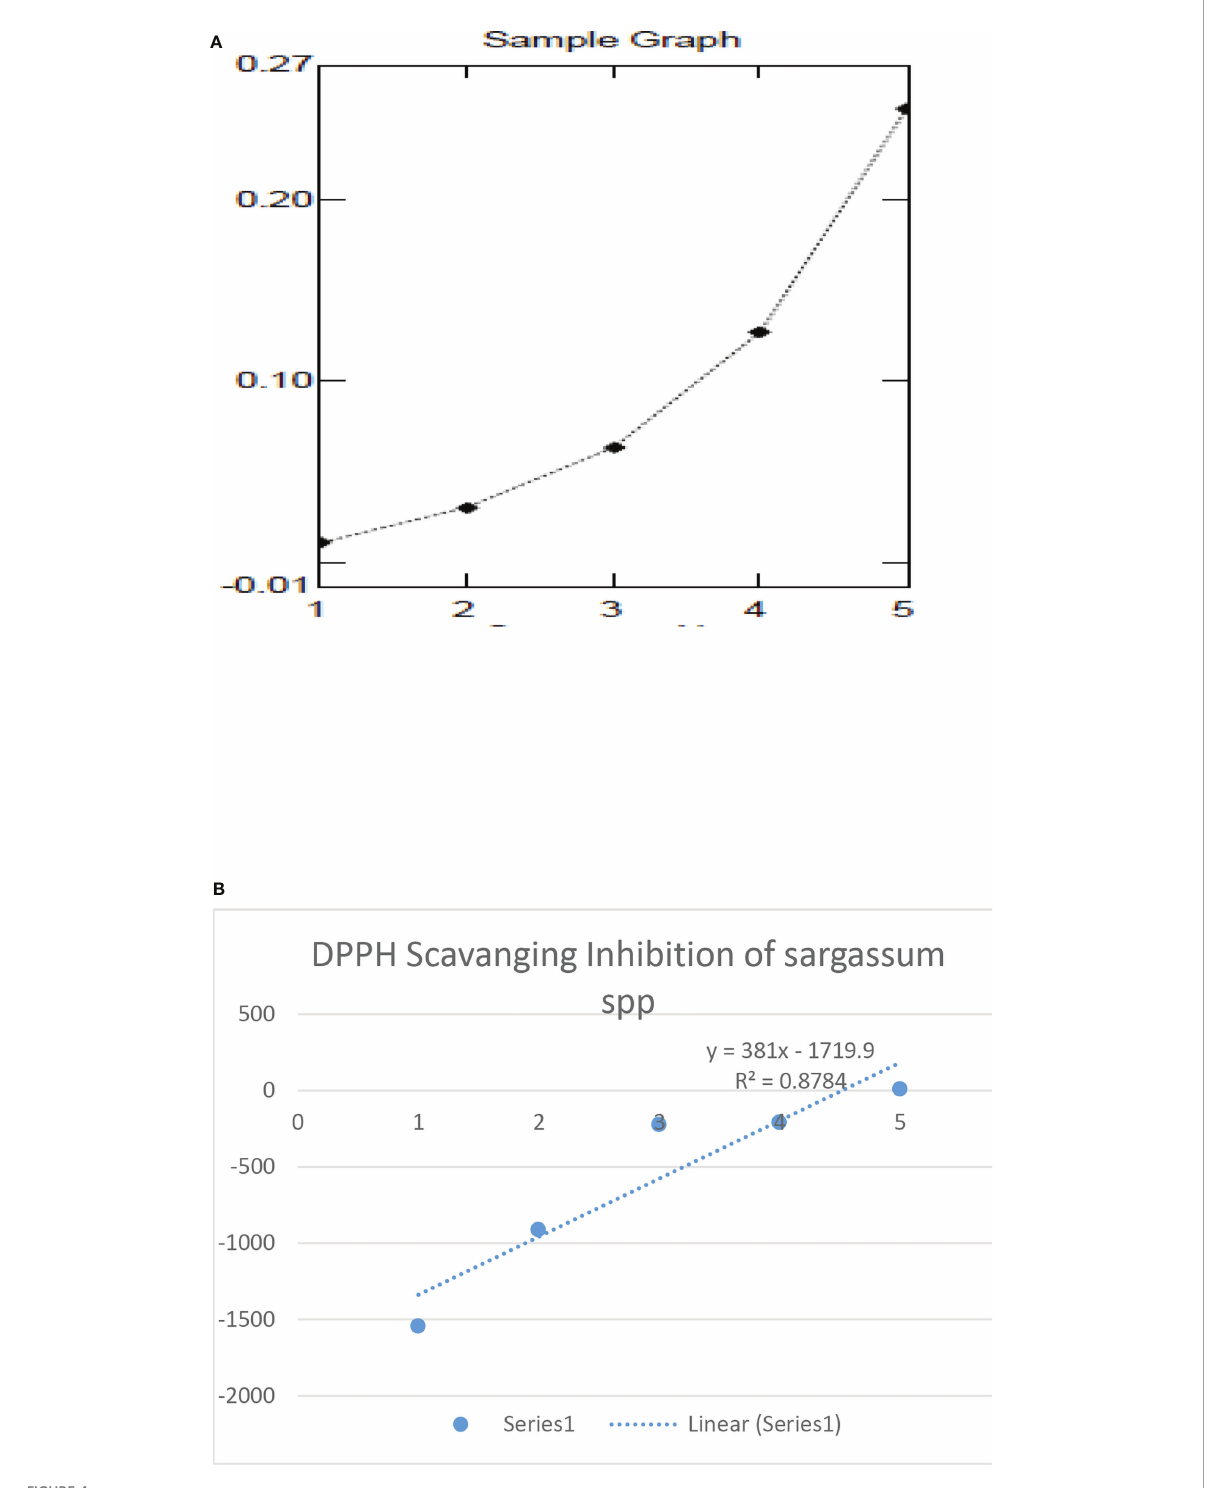
FIGURE 4 (A) Graph absorbance against concentration sargassum extract. (B) Inhibition % of with different concentration analyzed using DPPH radical scavenging